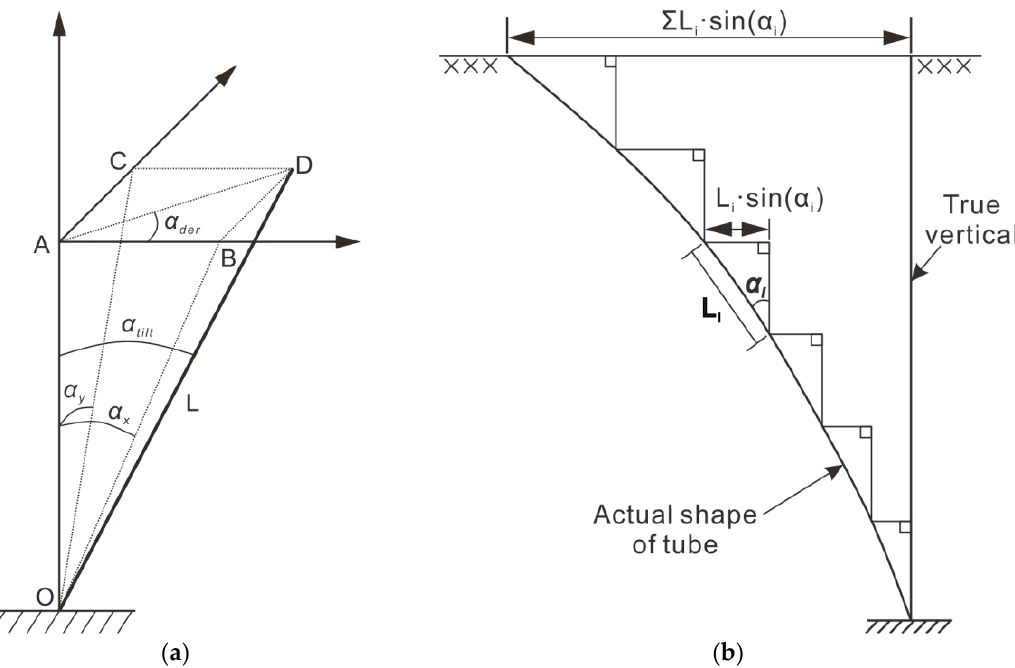
Figure 2. Calculation of displacement through the angle diagram: ( a ) Schematic diagram of angle to displacement conversion; ( b ) schematic diagram of cumulative displacement curves [31].